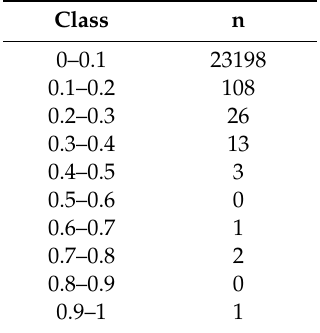
Figure 4. Time series of the amplitudes of the harmonics in the band 26.6 to 31.3 minutes extracted from the spectrograms. Note that scale of year 2016 is di ff erent from the others. The limited number of significant events does not clearly show a seasonal variability, although, excluding the event of October 2016, the highest peaks in spectrograms occurred more frequently in summer (July and August) and in February / March. Table 2. Distribution in classes of 0.1 amplitude of the normalized energy in the tsunami-band for the whole series (2009–2016) of analyzed